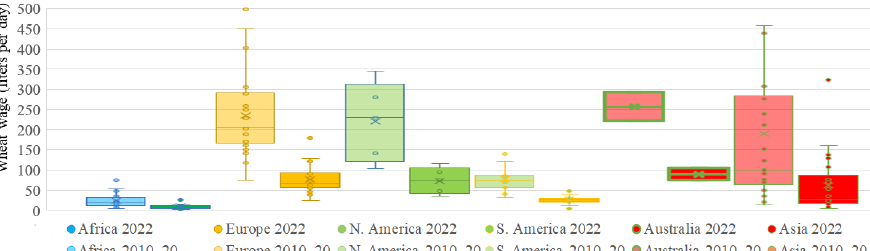
( b ) Figure 8. Income mountains (data adapted from [116] after transformation) marking the average wheat wage in antiquity. ( a ) 2016: wheat price average of 2010–2020 was about 210 € per ton; ( b ) 2022: wheat price was about 650 € per ton. Data accuracy is low as prices depend on local markets. 5. The Acceleration of “Green Growth” as a Defensive Method of West The collective Western thought is dominated by a Malthusian [117] perspective. The dominant narrative obeys the limits of growth and the alarm of overpopulation [118,119], degrowth [120–122], and “Green experiments” [123,124], even if related reports have highlighted that these lead to a costly failure [125,126]. Jordan Peterson [127] notes: Richer people care about “the environment”–which is, after all, outside the primary and fundamental concern of those desperate for their next meal. Social unrests caused by “Green” goals such as fertilizer and energy limitations, which lead to a rally of energy–food cost, have already emerged in the Netherlands [128], Sierra Leone [129], Peru [130], Argentina [131], Sri Lanka [132] and other countries [133].